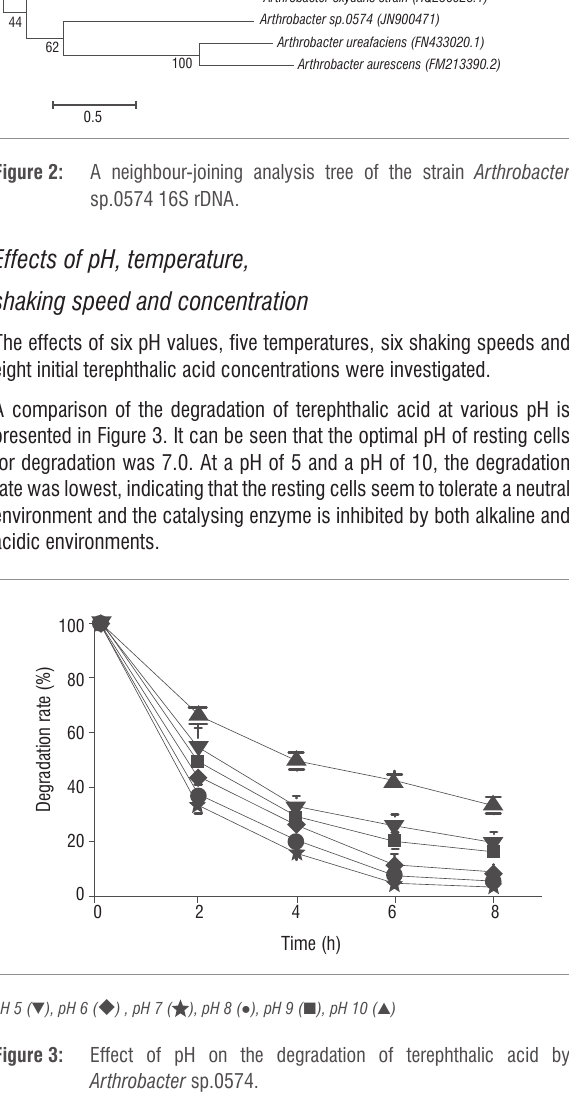
3 Volume 109 | Number 7/8